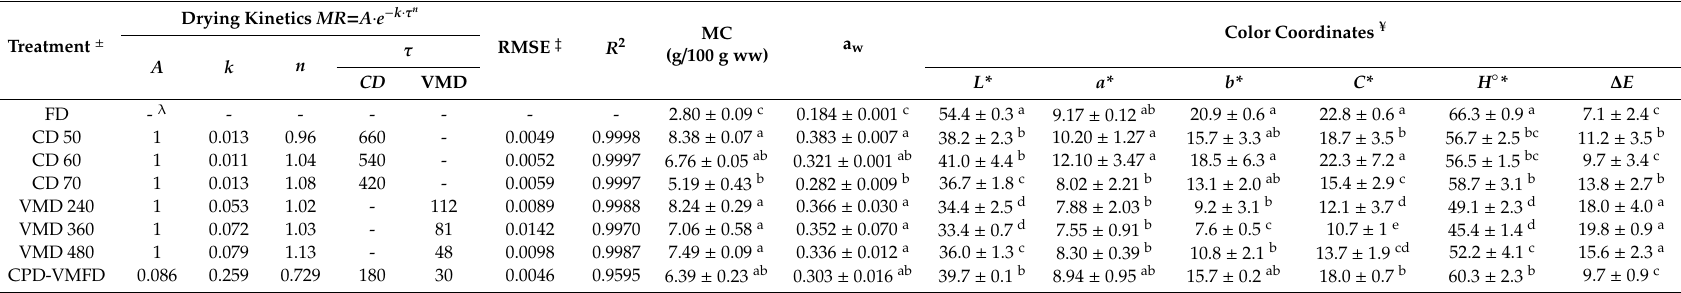
± Freeze drying (FD), convective drying (CD) at 50 ◦ C (CD 50), 60 ◦ C (CD 60) and 70 ◦ C (CD 70); vacuum-microwave drying (VMD) at 240 W (VMD 240), 360 W (VMD 360) and 480 W (VMD 480) and combined drying (CPD-VMFD). ¥ Mean values followed by di ff erent letter, within the same column, were significantly di ff erent ( p < 0.05). ‡ RMSE: root mean square error.; λ “-“ means no data available of this